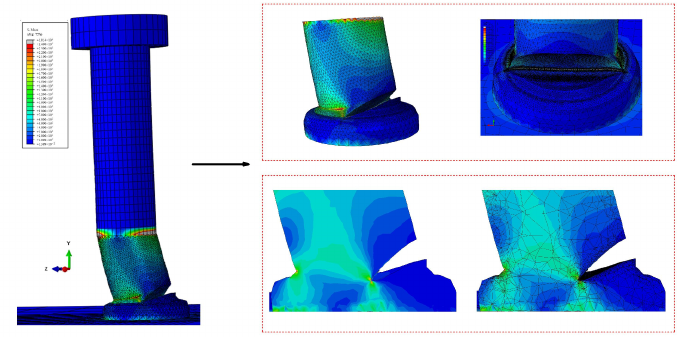
Figure 22. Fatigue crack pattern of studs.